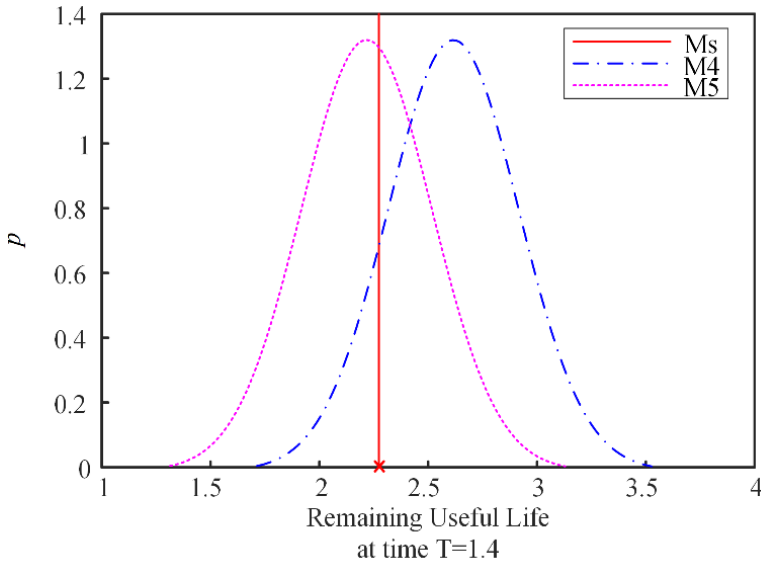
Figure 9. RUL PDF comparison.